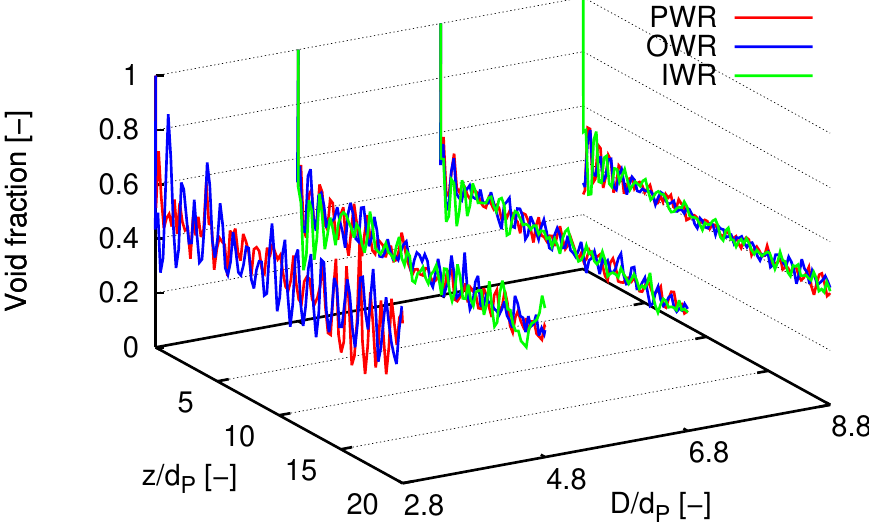
Figure 11. Axial void fraction